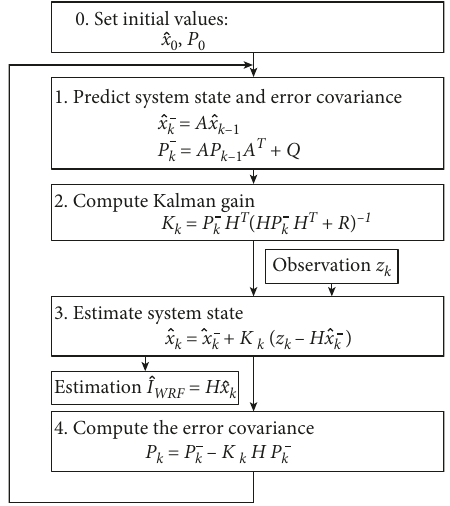
Figure 2: Algorithm of Kalman filter.